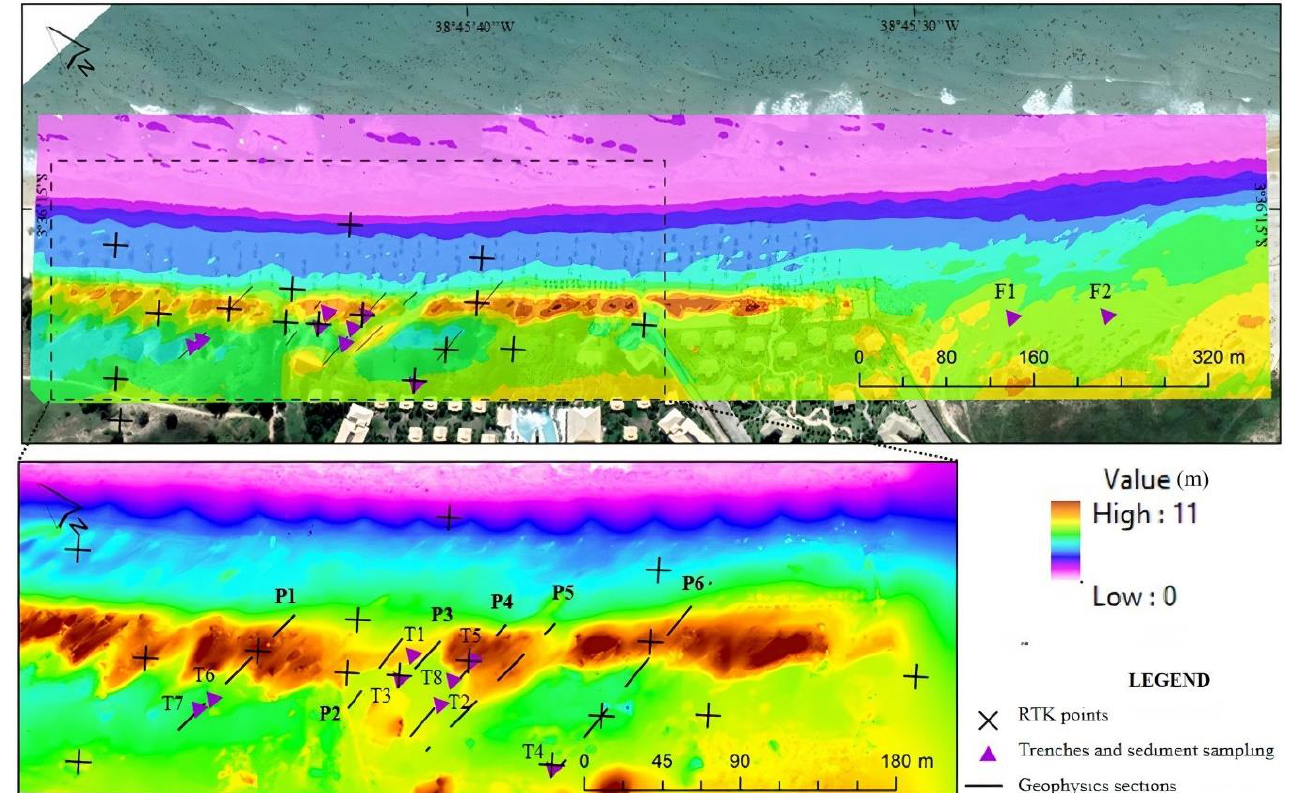
Figure 3. 3D map locating RTK points, treches (T1 to T7) and GPR sections (P1 P2,P3,P4,P5 and